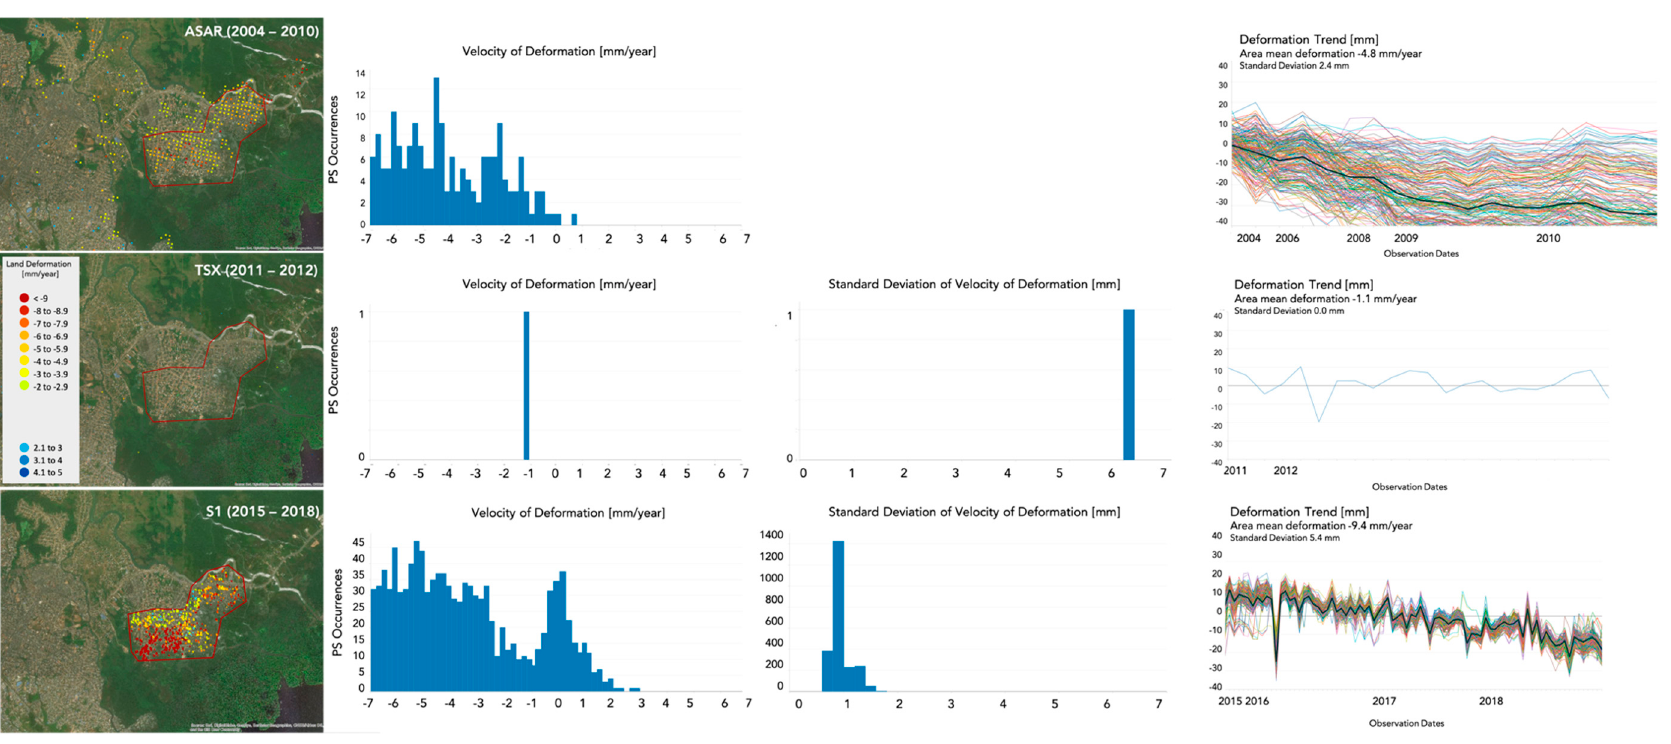
F igure 6. Lagos AOI 1, northeast. Figure 6. Lagos AOI 1,